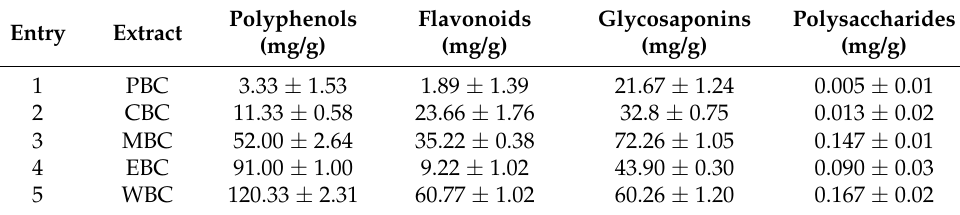
Table 3. Quantification of secondary metabolites in different extracts of flowers of Bombax ceiba L.